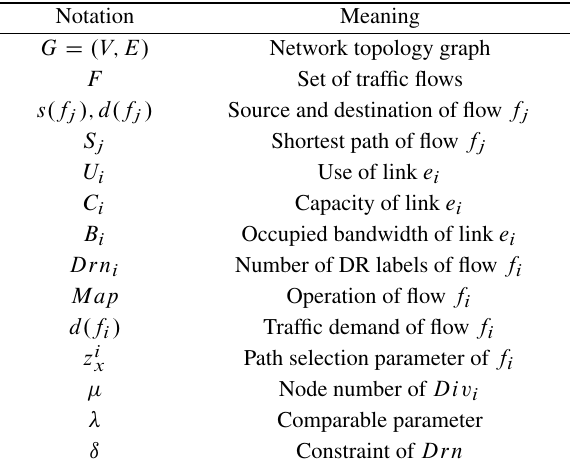
Table 1 Notation